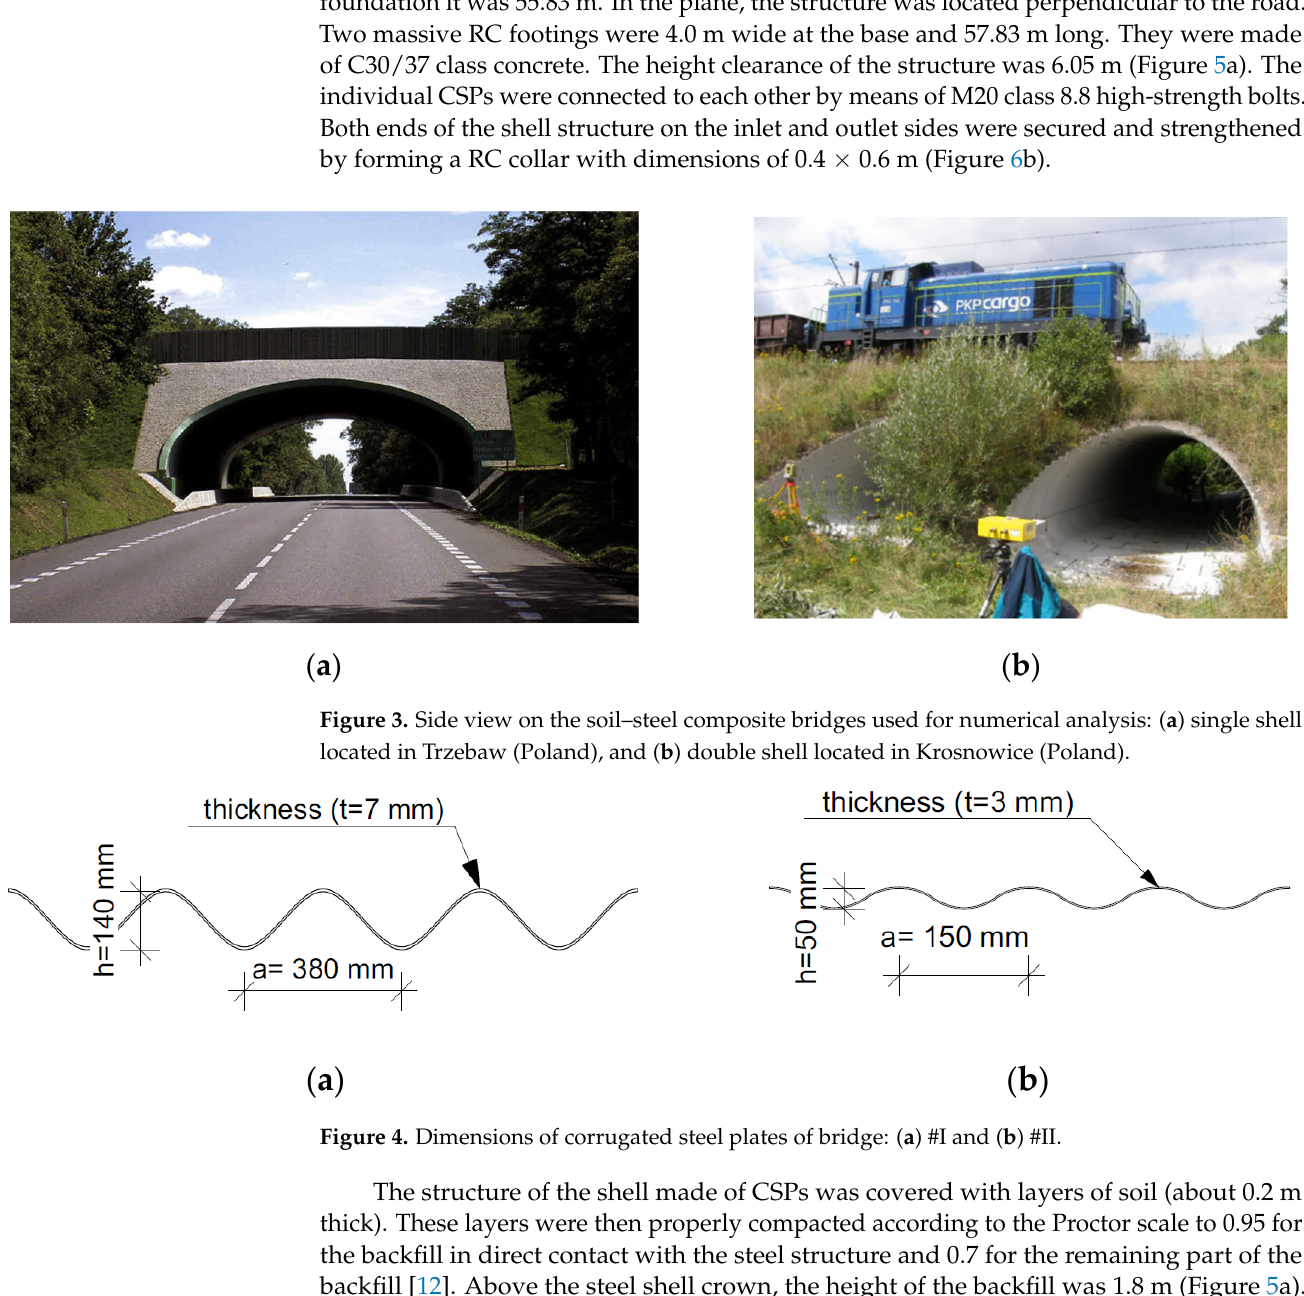
Figure 5. Cross section of: ( a ) bridge #I with single steel shell, ( b ) bridge #II with double steel shell.